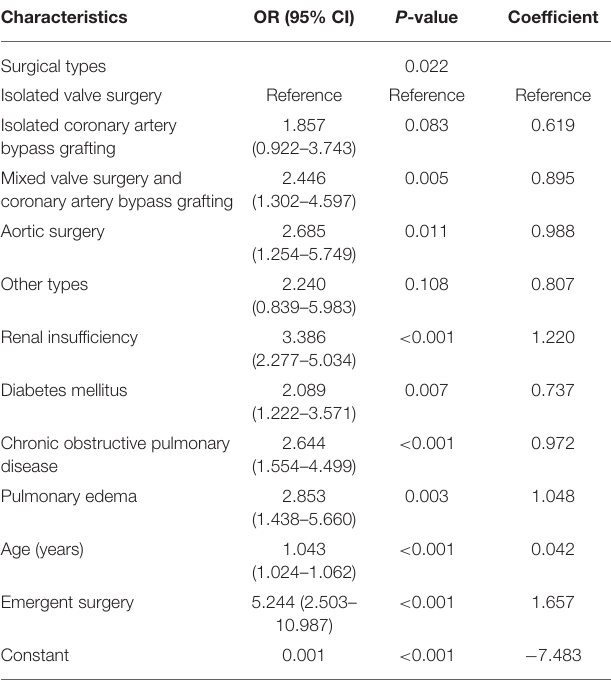
TABLE 2 | Multivariable analysis of independent risk factors for POT after cardiac surgery, without dichotomy of the continuous